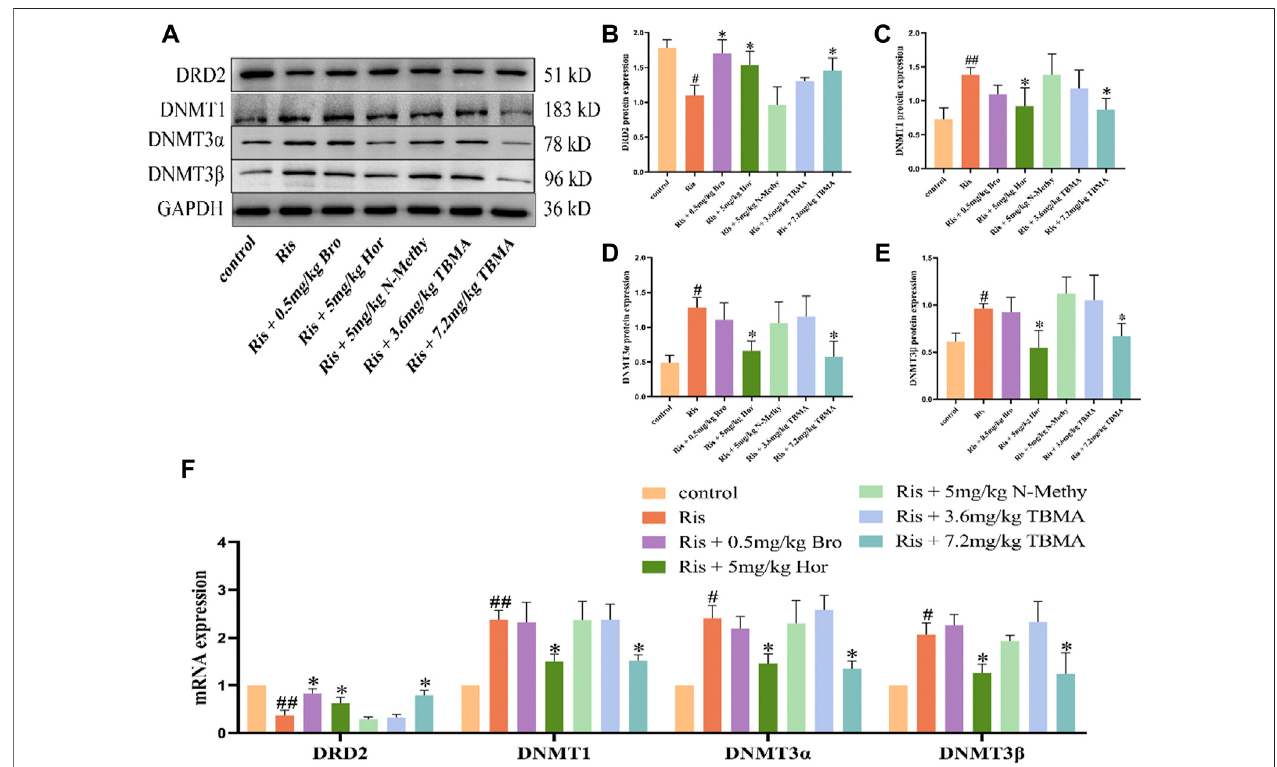
FIGURE 4 | Effects of TBMA, hordenine, and N-methyltyramine on DRD2 and DNMT expression. (A – E) DRD2, DNMT1, DNMT3 α , and DNMT3 β protein expression. GAPDH was used as a loading control. (F) DRD2, DNMT1, DNMT3 α , and DNMT3 β mRNA expression. Data are presented as the mean ± SD. Protein expression in each group was determined using western blotting. mRNA expression in each group was determined using RT-PCR ( n = 3 rats per group; # p < 0.05 and ## p < 0.01 versus the control group; *p < 0.05 versus the Model group. Bro = bromocriptine; Hor = hordenine; N-Methy = N-methyltyramine; Ris = risperidone; TBMA = total barley maiya